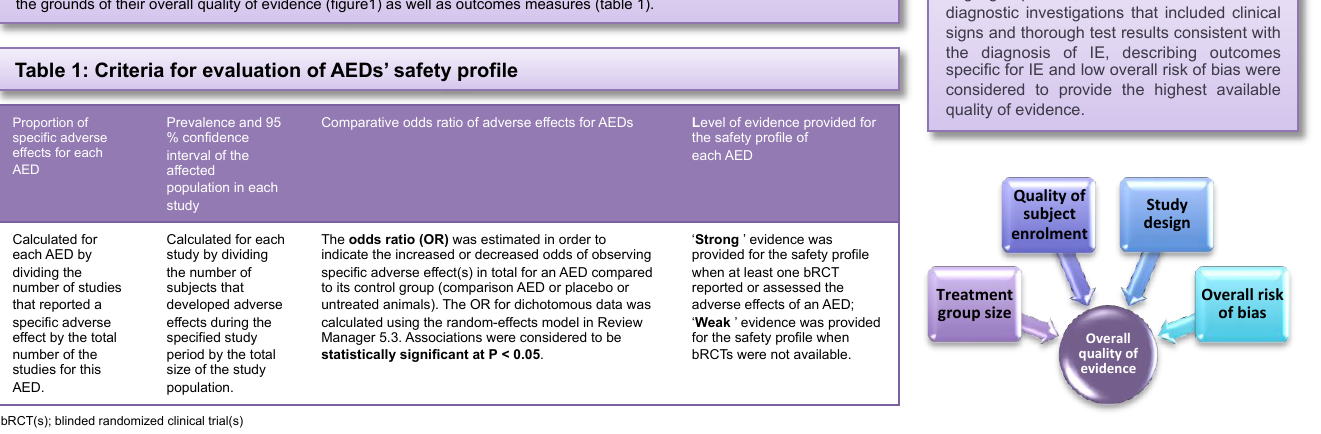
Figure 2: Risk of bias Risk of bias assessment presented as percentages across all included studies based on Cochrane and Syrcle’s ‘risk of bias’ assessment tool. Overall high risk of bias in >90% of the